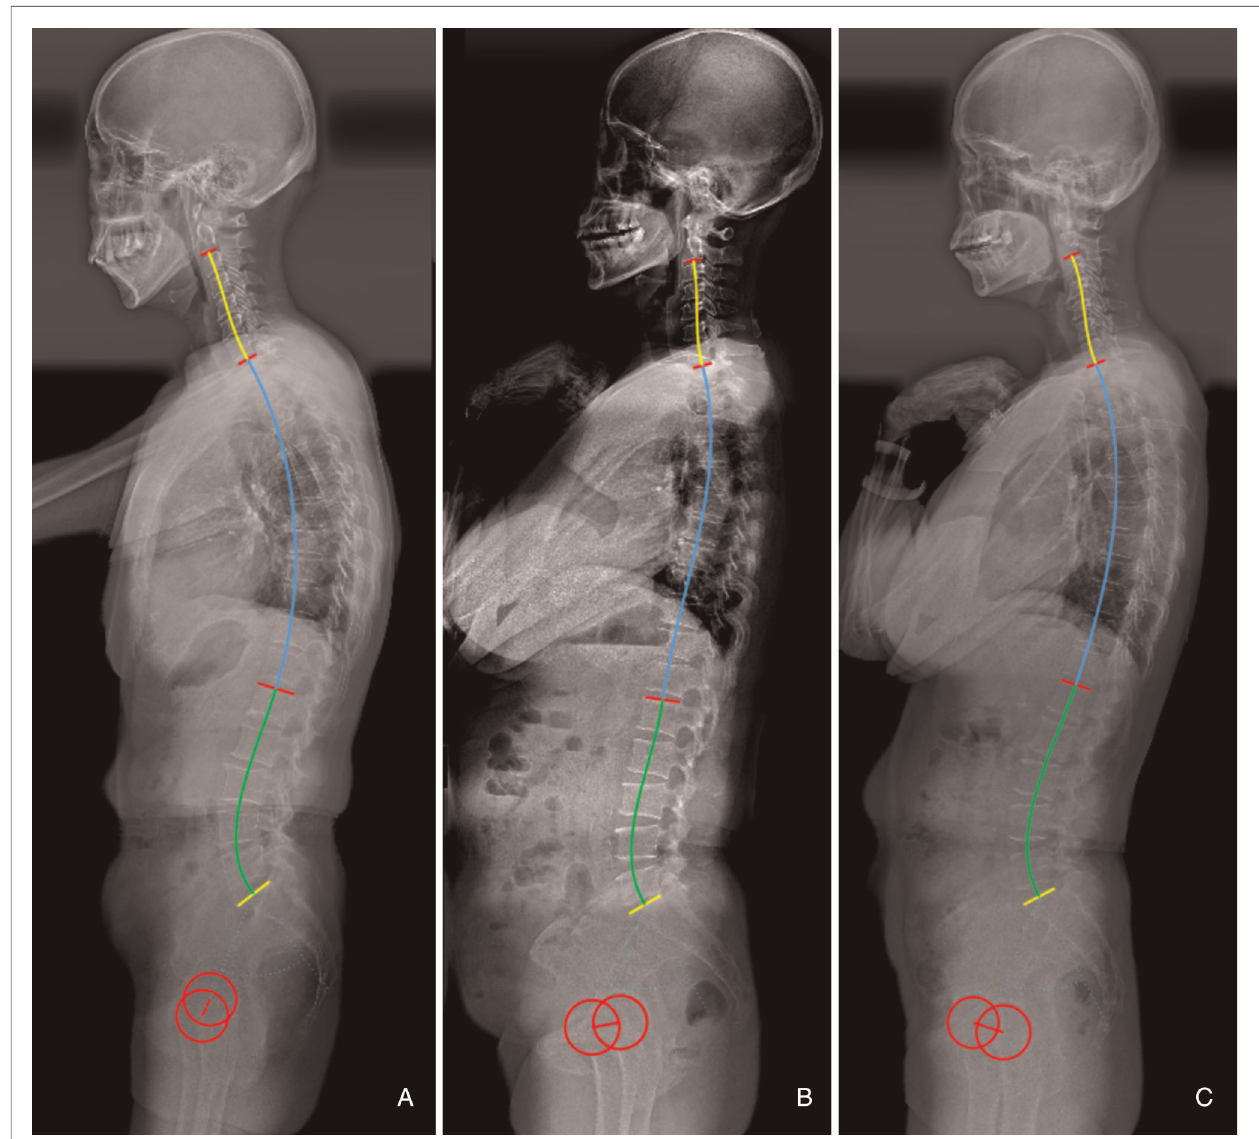
FIGURE 3 | ( A ) Male, 60 years old, with a large pelvic incidence (PI) (60.1°) and thoracic kyphosis (TK) (33.9°) resulting a hyperlordosis ( − 55.5°). ( B ) Female, 62 years old, with a moderate PI (48.3°) and fl at TK (8.9°), resulting a fl at LL ( − 38.5°). ( C ) Female, 53 years old, with a similar PI (49.1°) to b, but a larger TK (27.9°), resulting a larger LL ( −